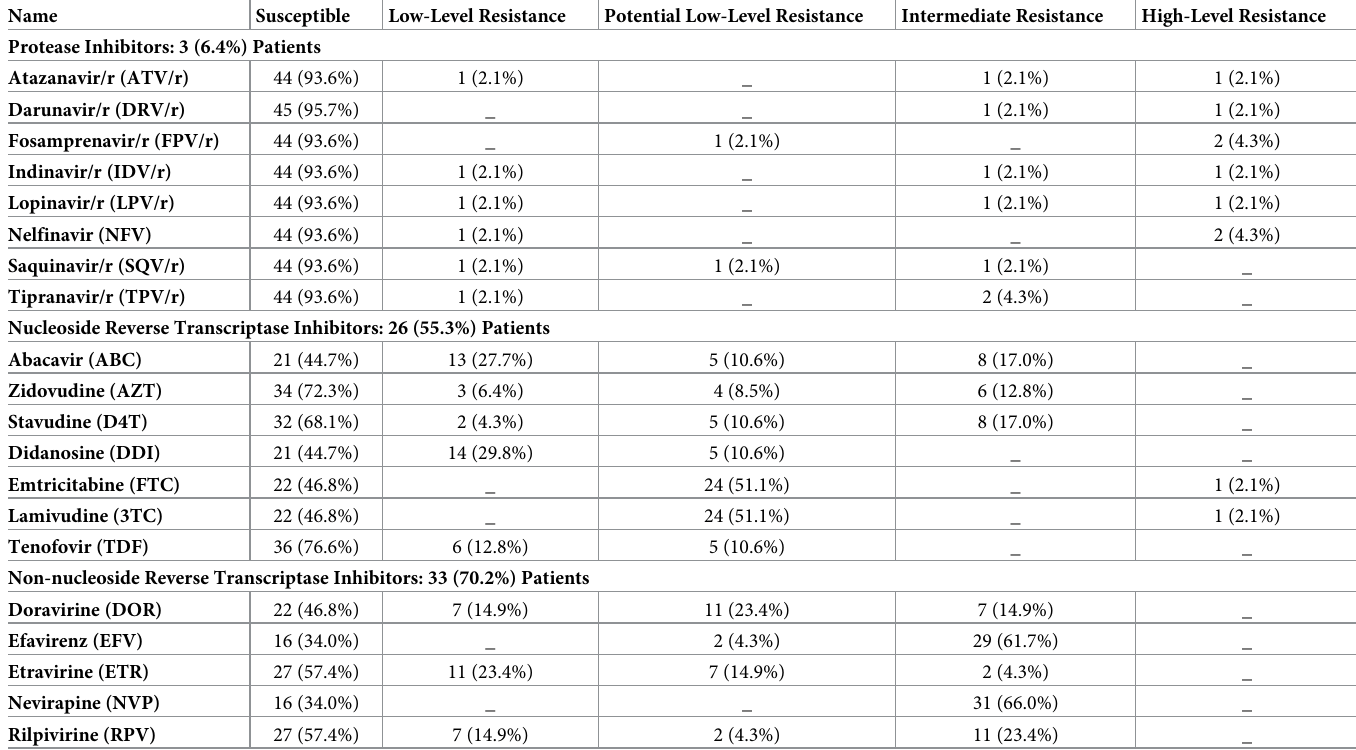
Table 5. The level of resistance to antiretroviral drugs among treatment-failed patients with HIV-1